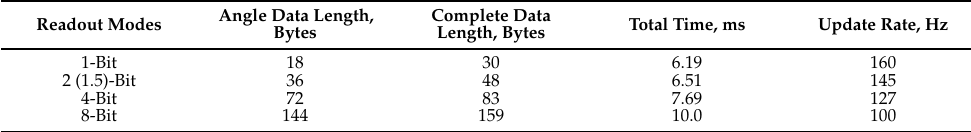
Table 3. Data packet sizes and refresh rates of different output